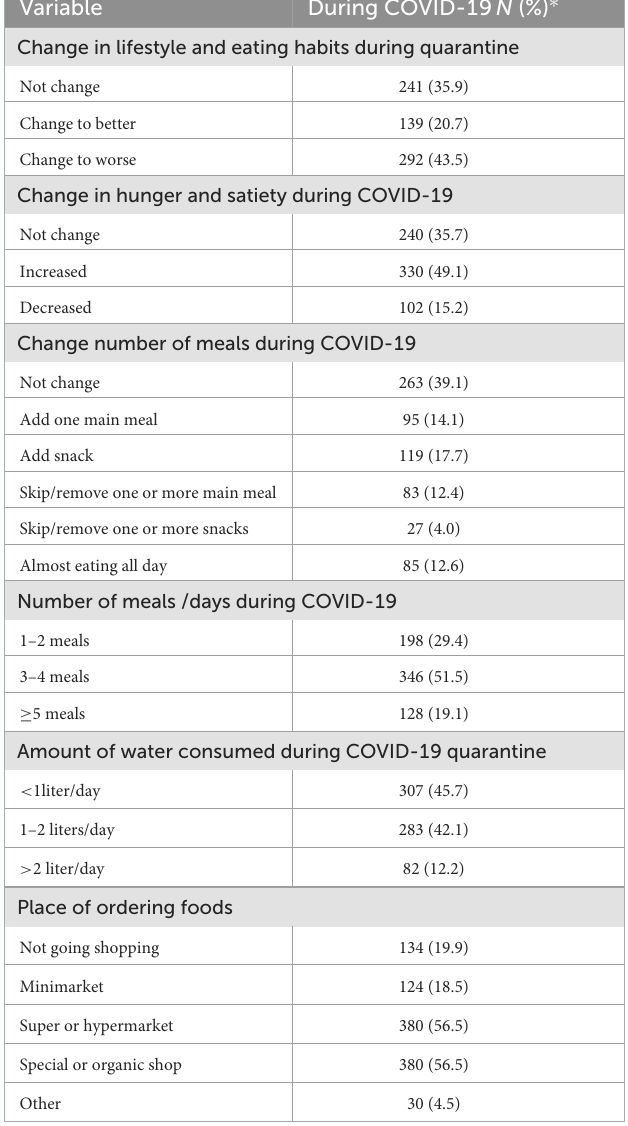
TABLE 4 Eating habits during COVID-19